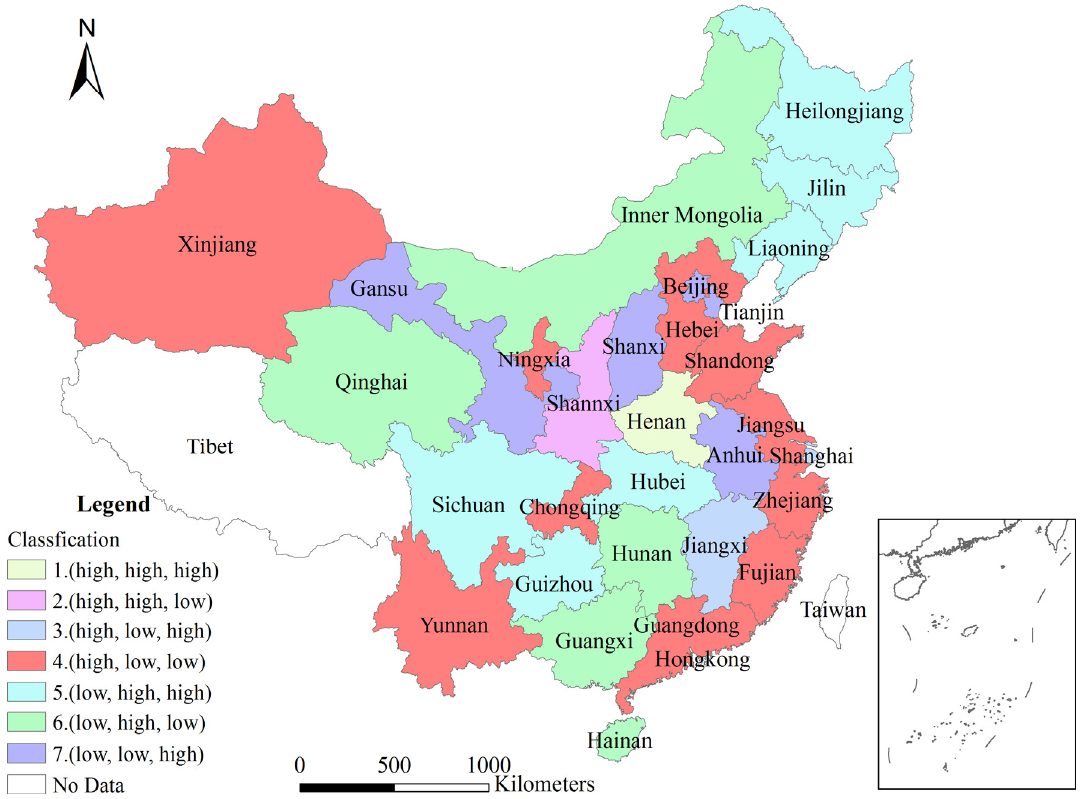
Figure 8. Distribution of provinces among different composite